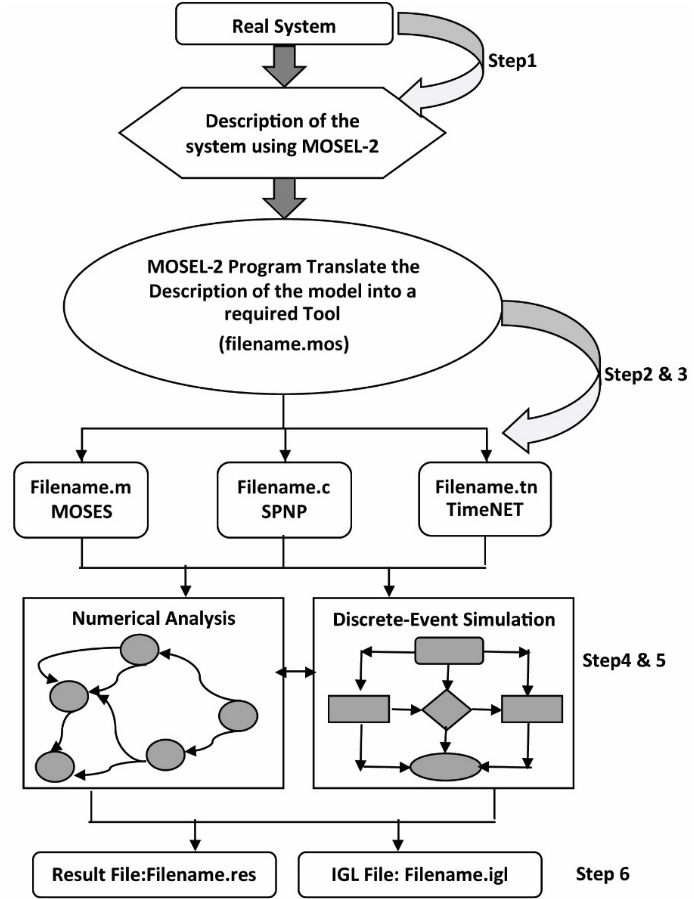
Figure 3. MOSEL-2 steps for model solution.